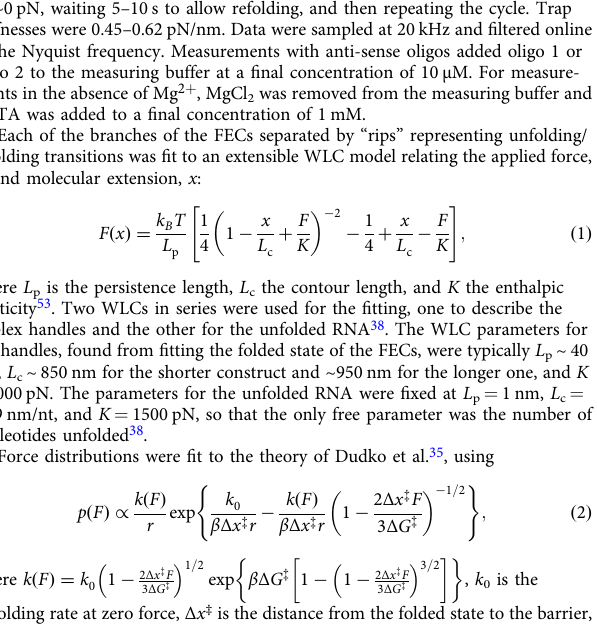
~160pM, mixing them with equal volumes of 600- and 820-nm diameter polystyrene beads (coated respectively with avidin DN and anti-digoxigenin) at concentrations of ~250 pM, and incubating the mixture for ~1 h at room temperature to create RNA-bead dumbbells. The incubation was then diluted ~100-fold into RNase-free measuring buffer: 50 mM MOPS pH 7.5, 130 mM KCl, 4mM MgCl 2 , and 200U/mL RNase inhibitor (SUPERase (cid:129) In, Ambion). An oxygen scavenging system consisting of 40 U/mL glucose oxidase, 185 U/mL catalase, and 250 mM D-glucose was also included in the buffer. The diluted dumbbells were placed in a fl ow chamber prepared on a microscope slide and inserted into the optical